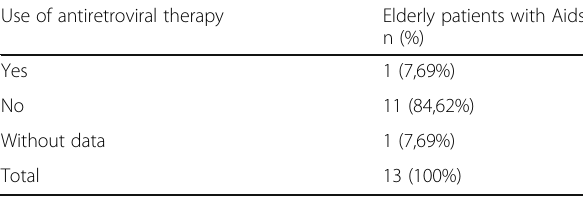
Table 3 Distribution of use of antiretroviral therapy in elderly patients with Aids autopsied in the period from 1982 to 2014 Use of antiretroviral